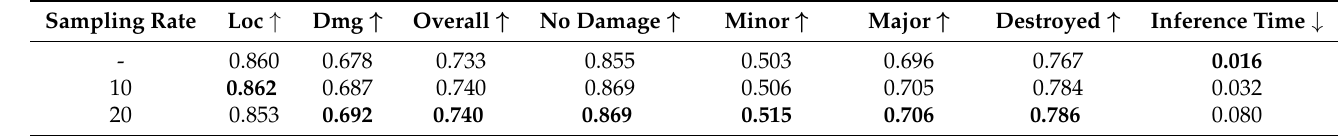
Figure 8. The qualitative examples of generative uncertainty maps. The houses in the red boxes indicates where the uncertainty arises due to poor illumination. Table 4. The illustration of the relation between sampling rate and fusion operators when MC Dropout is applied. When the sampling rate is set as 20, the assessment performance is the best, while the inference time is doubled.